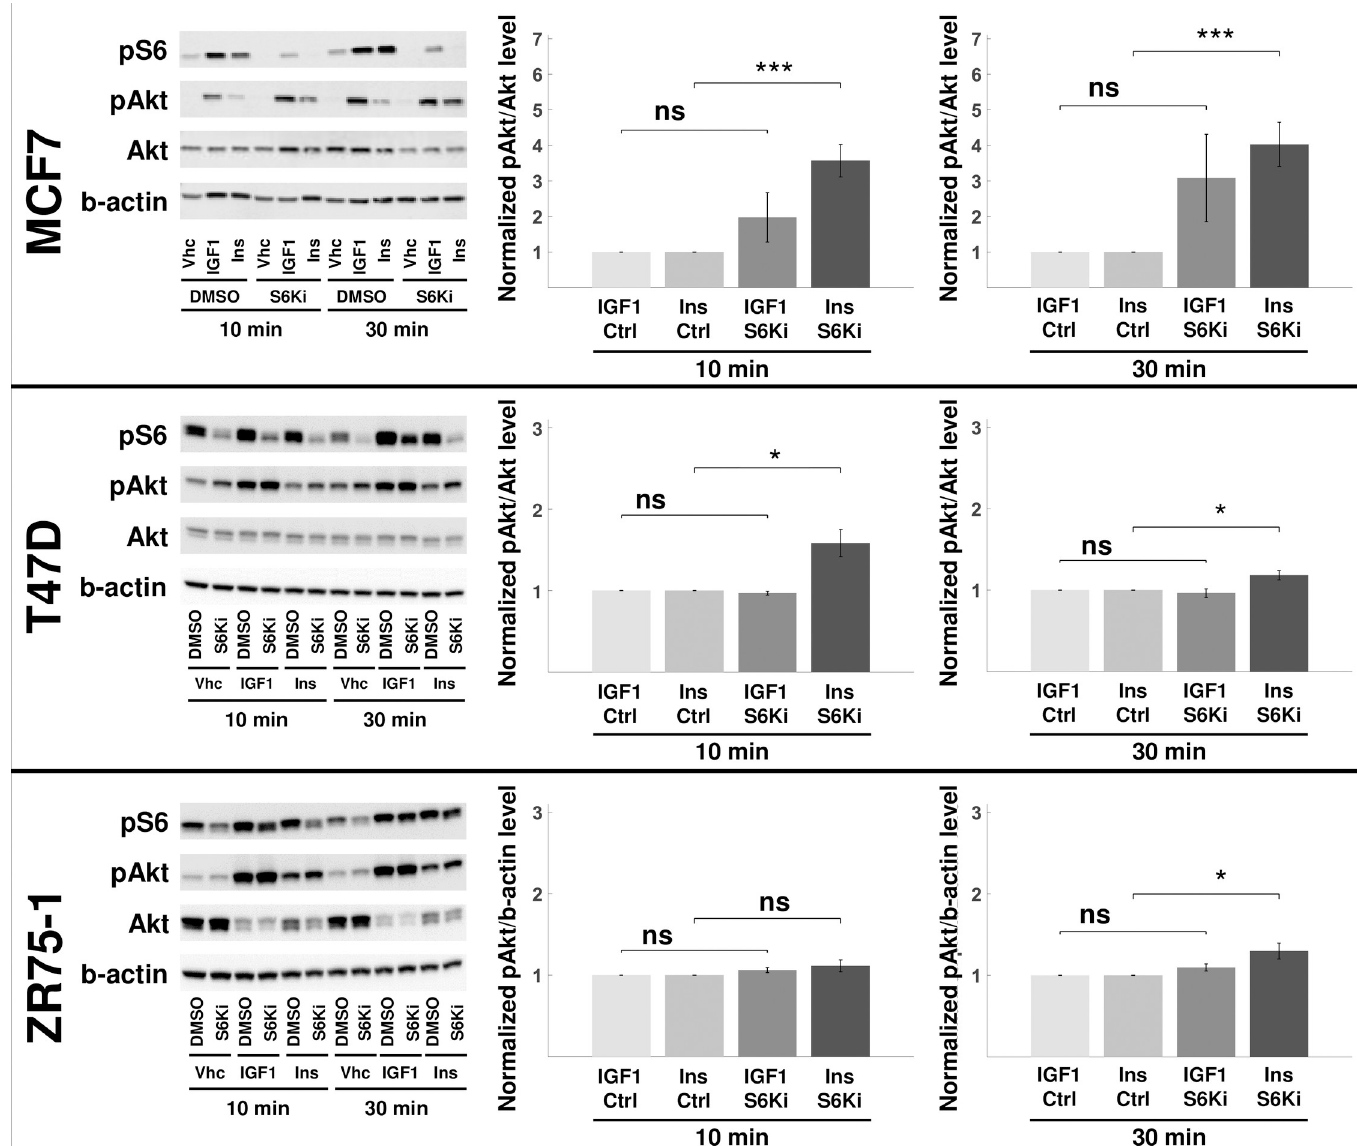
Fig 4. Ribosomal S6 kinase inhibition up-regulates Akt phosphorylation. The RPS6K was inhibited in MCF7, T47D, and ZR75-1 cells. The pS6 levels are used as the proxy for S6K inhibition efficiency. The total Akt and b-actin levels are used to normalize pAkt and pS6 levels, respectively. The perturbagen, ligand, and time point for each sample are listed below the blot images (the rest of the replicates are shown in S9 Fig). The blot quantifications are shown on the right. The values are reported as normalized to the corresponding no-inhibition control (ctrl). pAkt levels represent the response of the cells to the perturbation. All MCF7, T47D, and ZR75-1 cell lines showed higher up-regulation of pAkt in insulin-stimulated cells at 30 min. The results are compared using an unpaired, one-tailed two-sample t-test, and P < 0.05 ( � ), P < 0.01 ( �� ), P < 0.005 ( ��� ), nonsignificant (ns). Results shown are mean ± s.e.m. of four independent replicates. S6 phosphorylation quantifications at 10 and 30 min are shown in S10